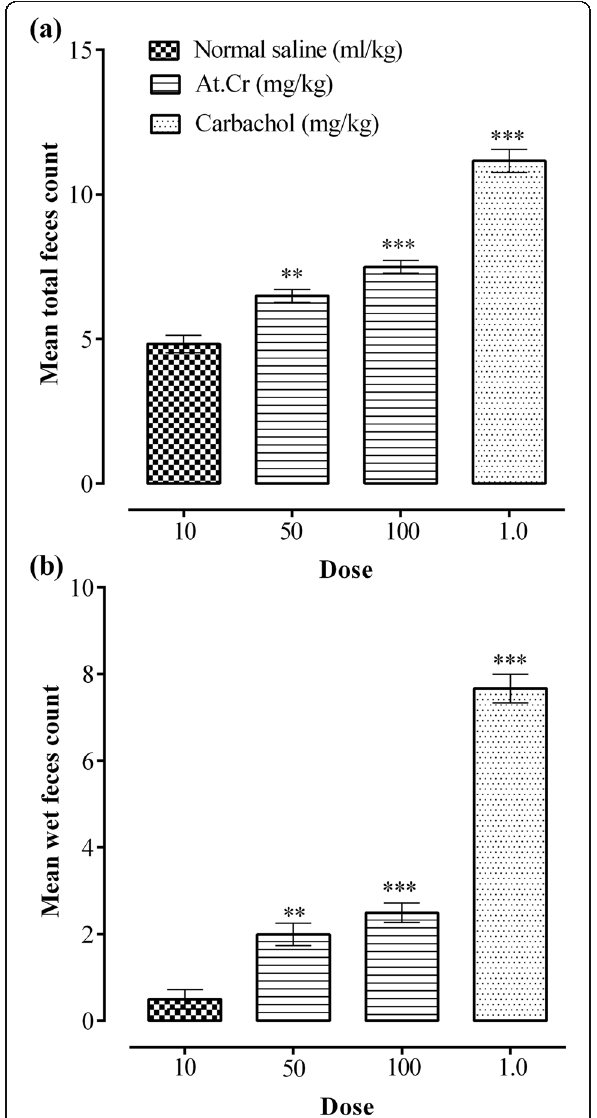
Fig. 3 Effects of Asphodelus tenuifolius crude extract (At.Cr) and carbachol upon ( a ) total feces and ( b ) wet feces output in mice. ** p < 0.01 and *** p < 0.001 versus saline treated control group. Values are mean ± SEM ( n =